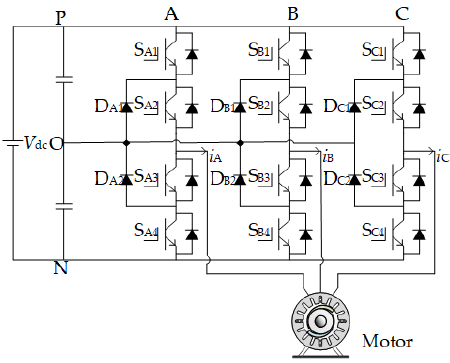
Figure 1. The topology of neutral-point-clamped three-level inverter.